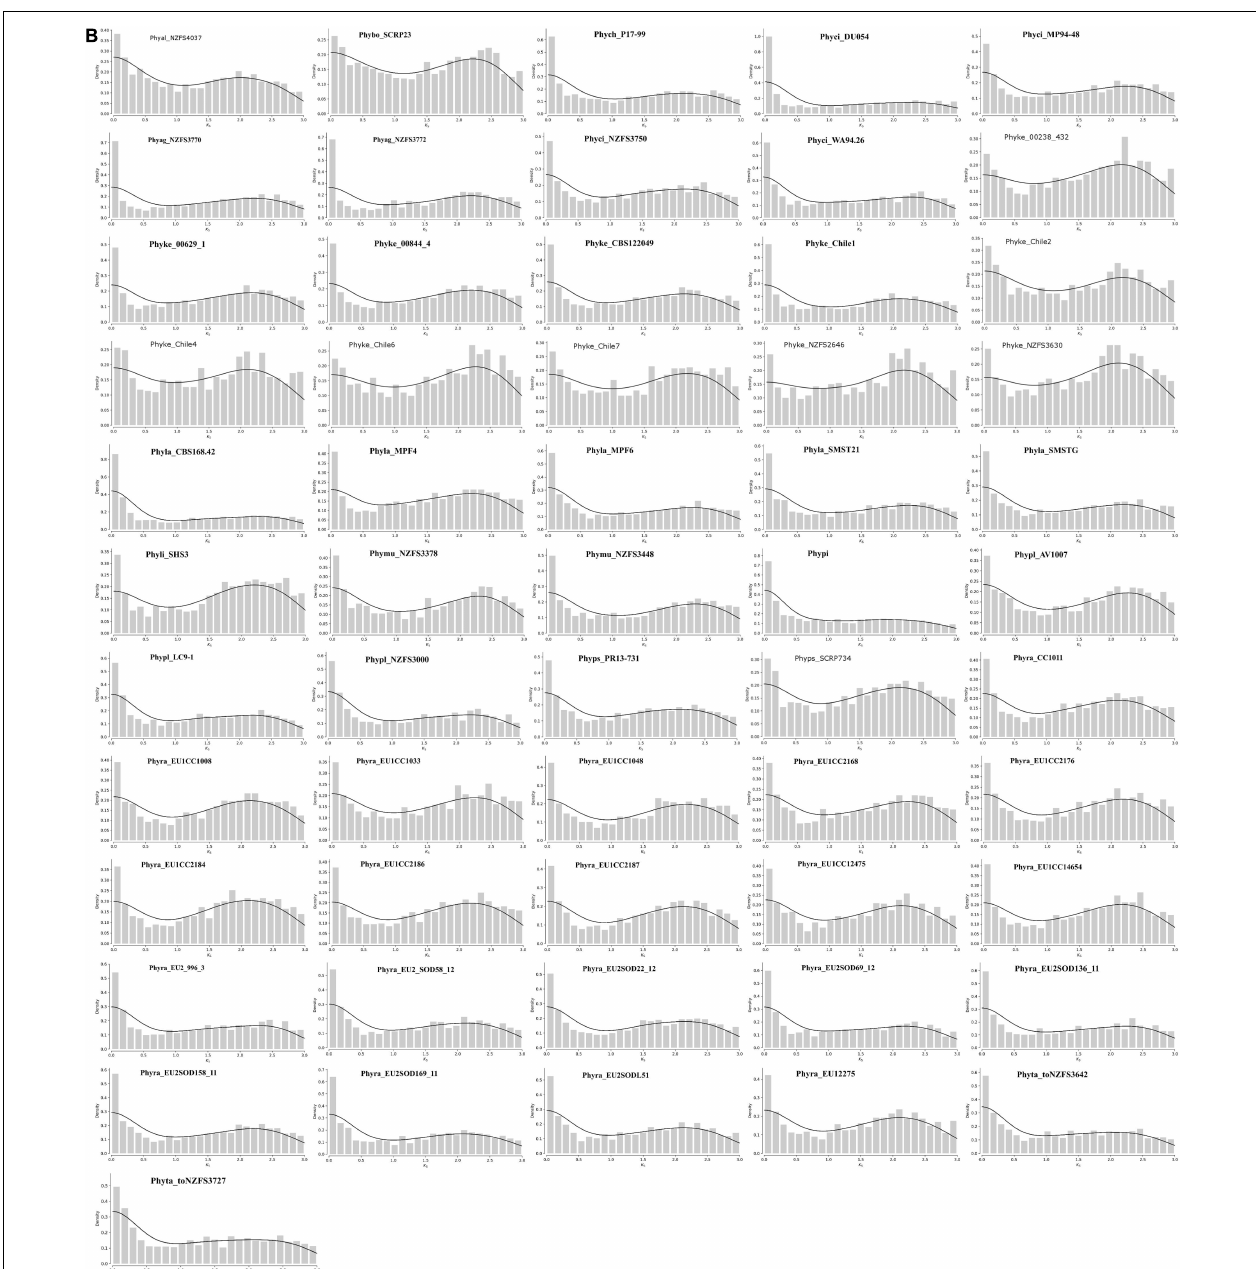
FIGURE 6 | K s distribution of full paranomes. (A) Type-I whole genome duplication with KDEs of peaks in the K S . Exponential decrease represents L-shaped curve that indicates whole genome duplication in ancestral time and loss of many duplicate genes. (B) Type-II whole genome duplication with KDE. Peaks in the K s at 2–2.5 indicate increase of duplication